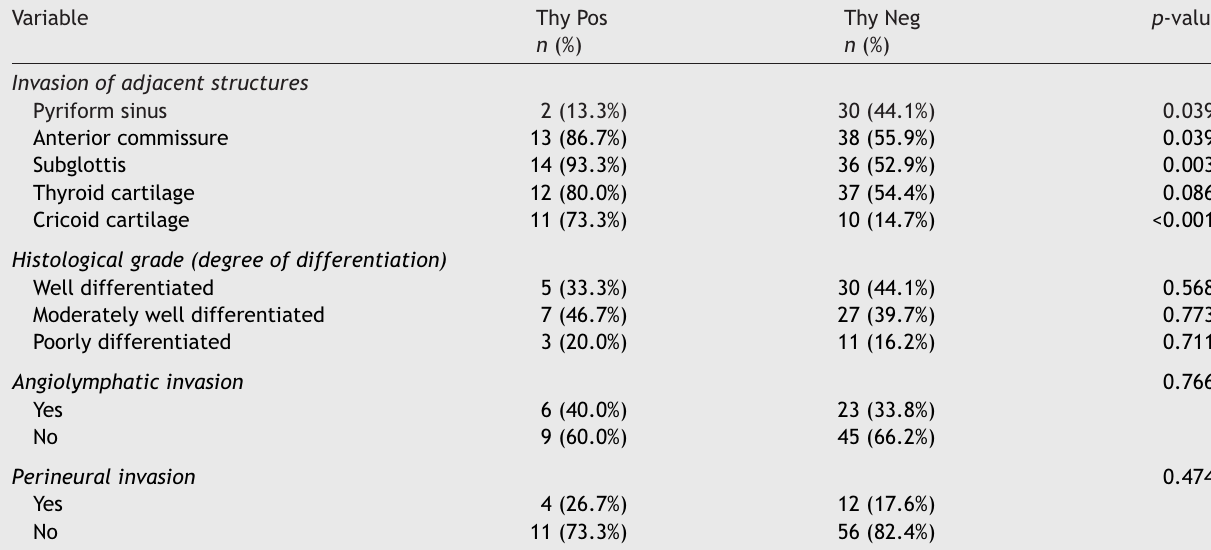
Comparison between groups of patients with laryngeal and/or hypopharyngeal SCC submitted to TL or TPL with HT or TT --- anatomopathological